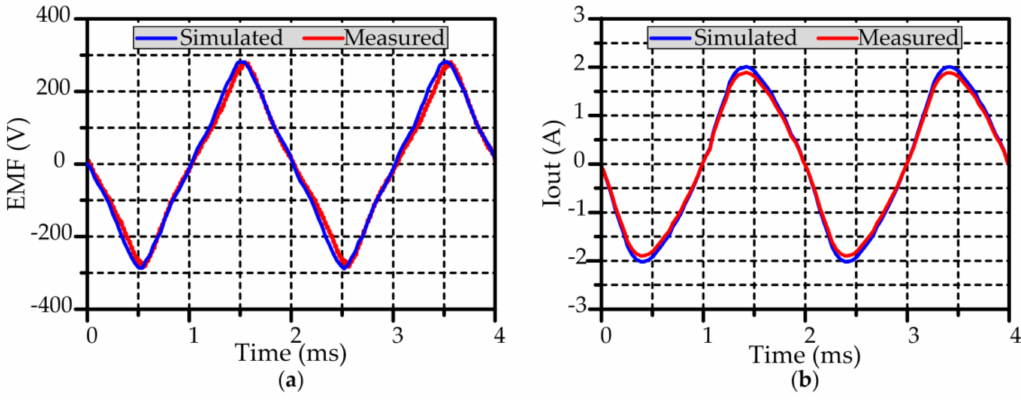
Figure 23. Measured and simulation results: ( a ) No-load EMF at 2500 r/min; ( b ) Load current with 90 Ω resistance and at 2500